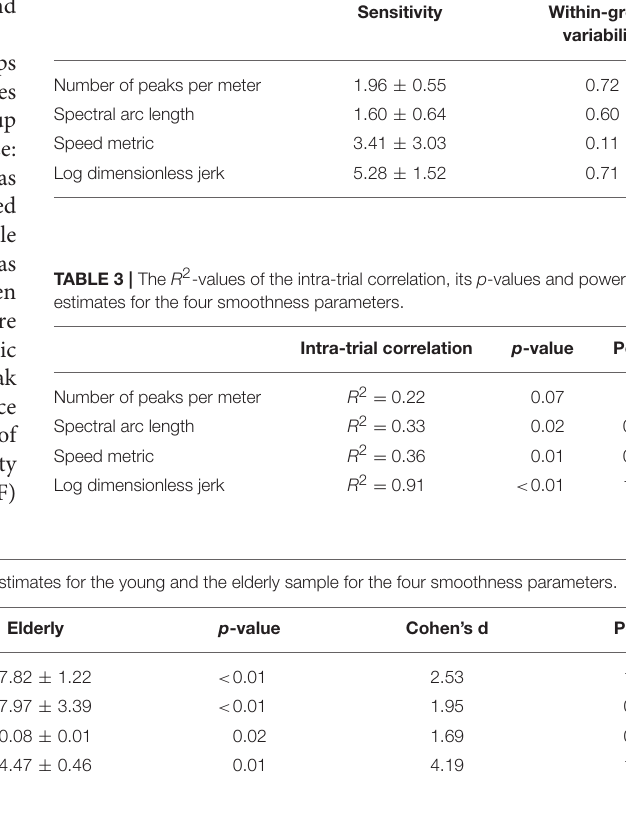
Number of peaks per